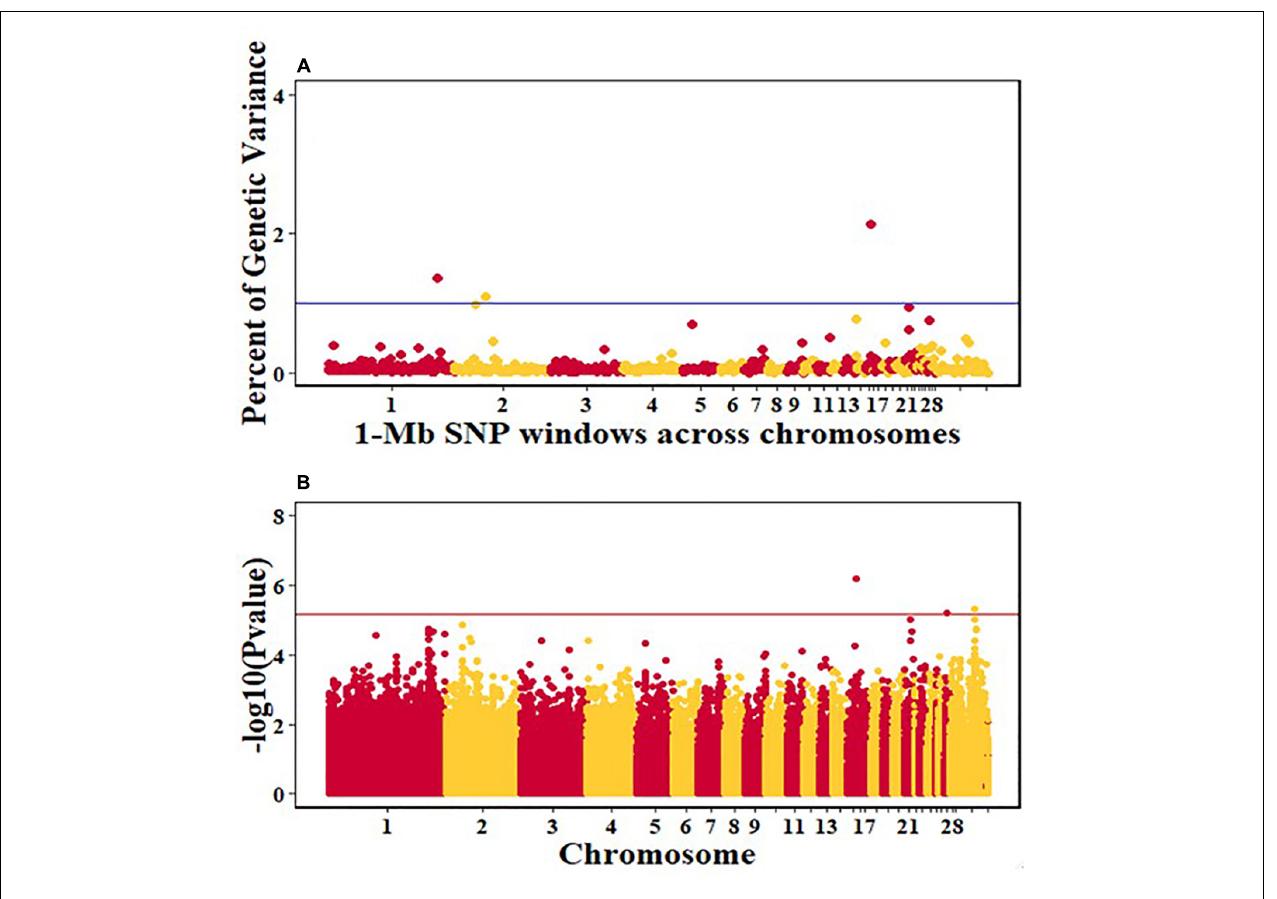
FIGURE 3 | Manhattan plots showing the genome-wide association results for pre-infection growth rate in the Ghana local chicken ecotypes population, using Bayes-B and single-SNP analyses. (A) Bayes-B results showing the percent of genetic variance explained by SNPs in 1-Mb non-overlapping window across chromosomes. (B) Single-SNP results showing the -log10( p -value) of ordered SNPs across the chromosomes. The blue and red lines indicate genome-wide significance at 1% genetic variance and 20% genome-wide suggestive association,